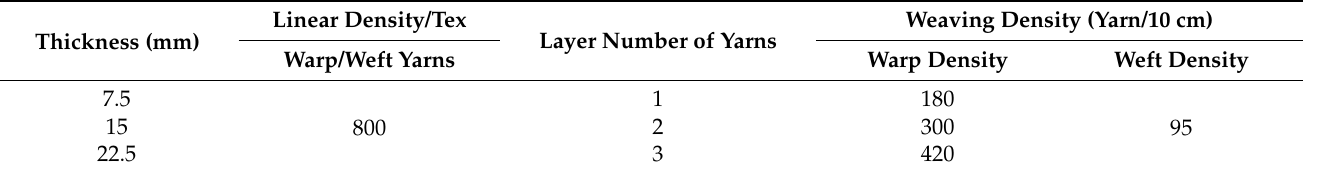
Table 1. Weaving parameters of 3-D honeycomb woven fabrics.